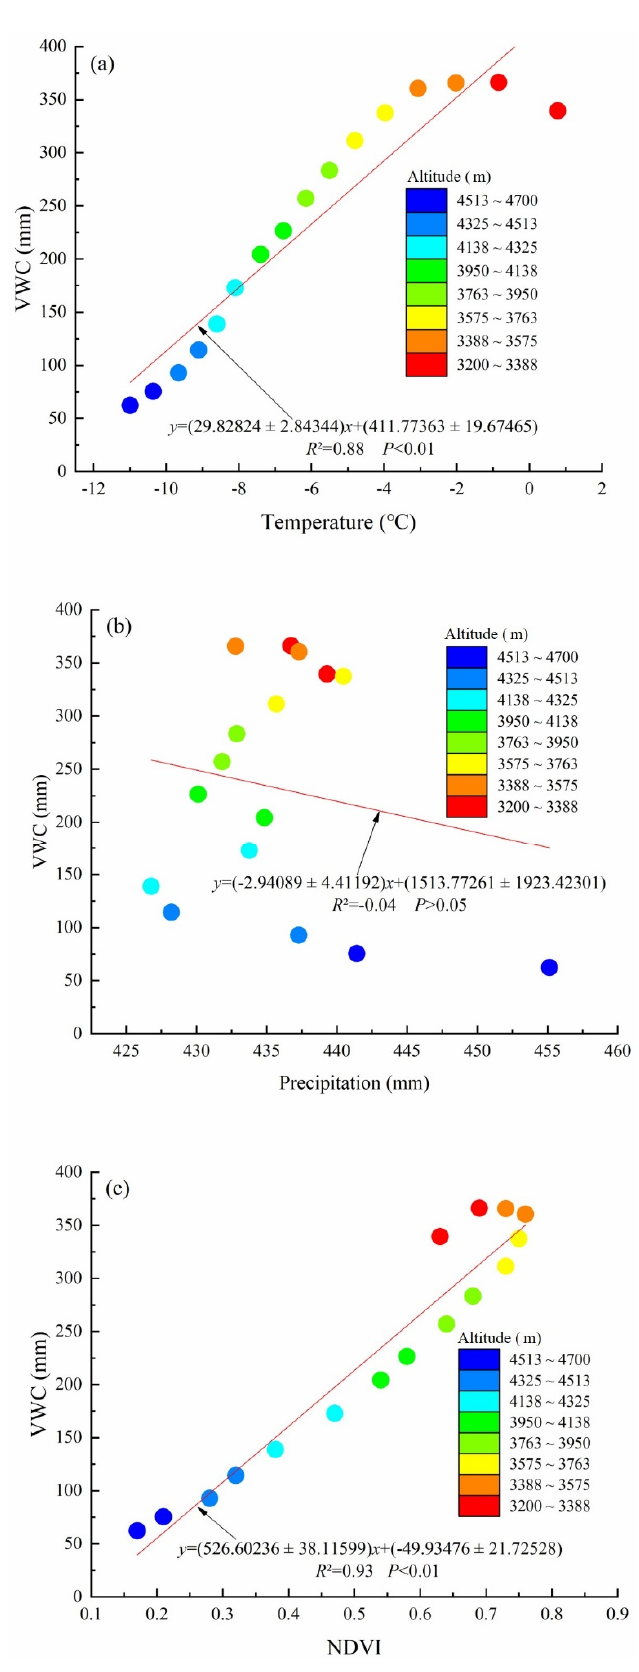
Figure 14. Linear relationships between annual average temperature ( a ), precipitation ( b ), NDVI ( c ), and VWC along the altitude gradient in the Qinghai Lake Basin from 2015 to 2020.